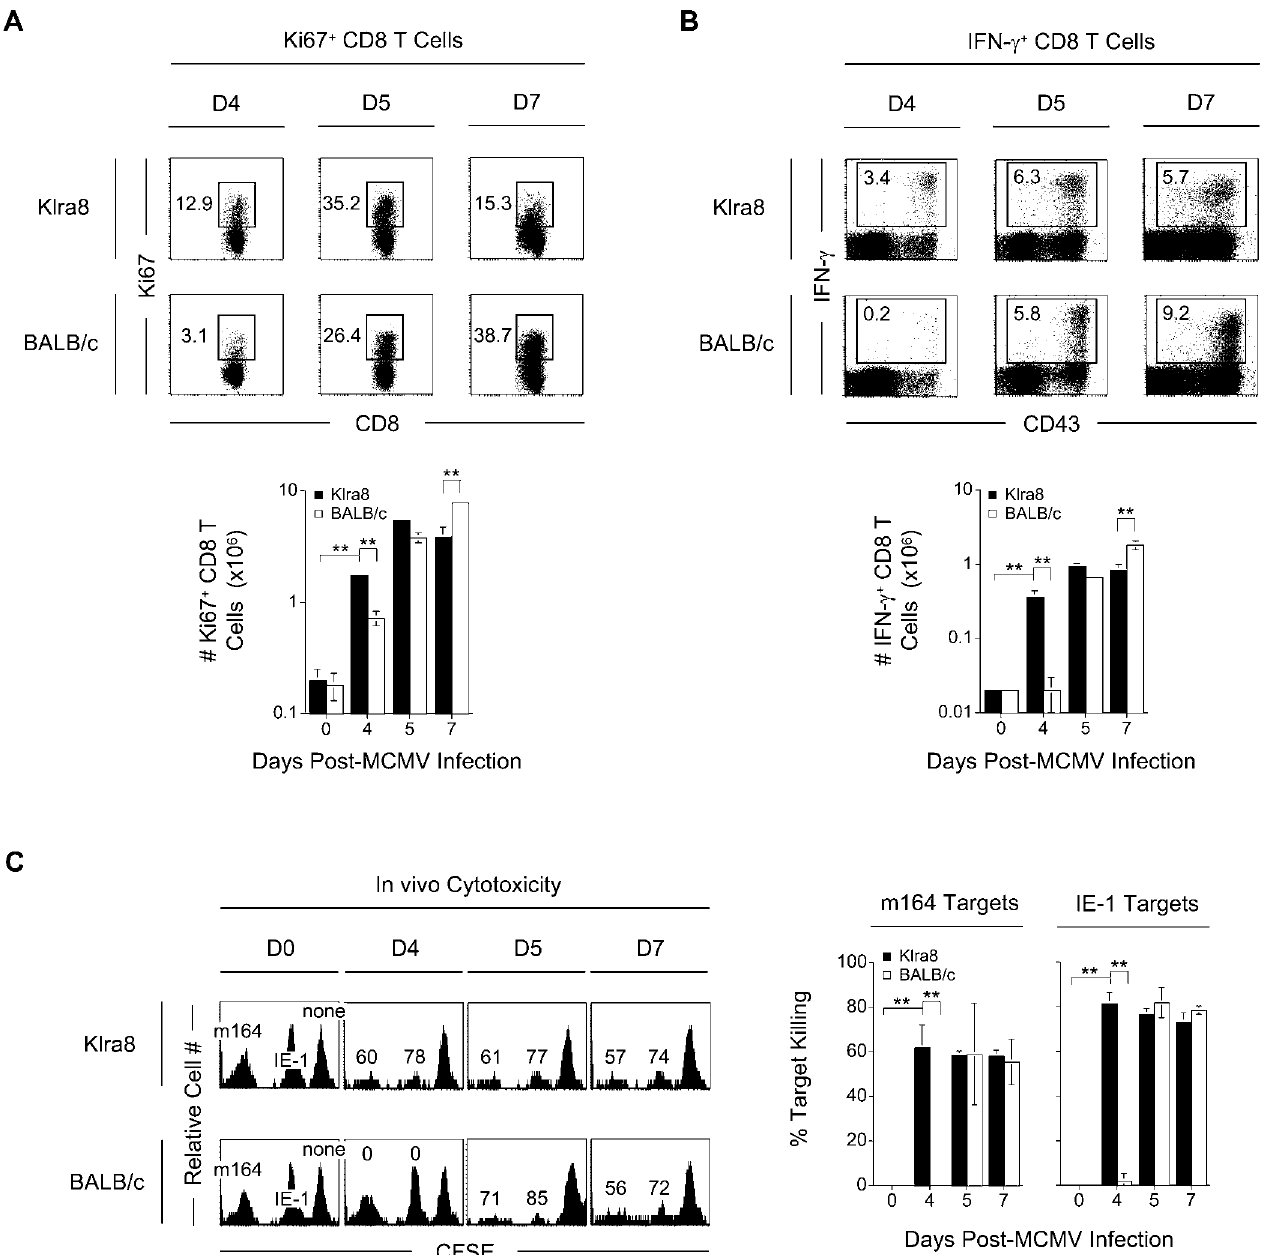
Figure 4. Accelerated Acquisition of CD8 T Cell Effector Functions in Klra8 Mice in Response to MCMV Infection Splenic leukocytes were isolated from Klra8 and BALB/c mice on days 0, 4, 5, and 7 post–MCMV infection. (A) The CD8 T cell population was analyzed directly ex vivo for intracellular expression of Ki-67. Intracellular expression of Ki-67 is shown for one representative animal from groups of three mice for days 4, 5, and 7 post–MCMV infection. Numbers in dot plots represent percent Ki-67 þ CD8 T cells within the total CD8 T cell population. Graphs represent the total numbers (in millions) of Ki-67 þ CD8 T cells. (B) The CD8 T cell populations were analyzed for their ability to produce IFN- c after antigen-specific re-stimulation with IE-1 peptide-pulsed P815.B7 cells. Intracellular expression of IFN- c is shown versus surface CD43 expression for the total CD8 T cell population for one representative animal from groups of three mice. Numbers in dot plots represent percent IFN- c þ CD8 T cells within the total CD8 T cell population. Graphs represent the total numbers (in millions) of IFN- c þ CD8 T cells. (C) The CD8 T cell populations were analyzed for their ability to kill IE-1 and m164 peptide-pulsed target cells in vivo. Target cells were transferred into mice at the time points indicated and the spleens harvested 4 h later. Histograms are gated on PKH26 þ target cells. Numbers represent the percentage of target cells killed for one representative animal from groups of three mice. Graphs represent the percentage of target cells killed. Results in graphs are expressed as mean 6 SD of three mice per group for (A–C). One experiment representative of three for (A, B), and two for (C) are shown. ** p (cid:3) 0.01.